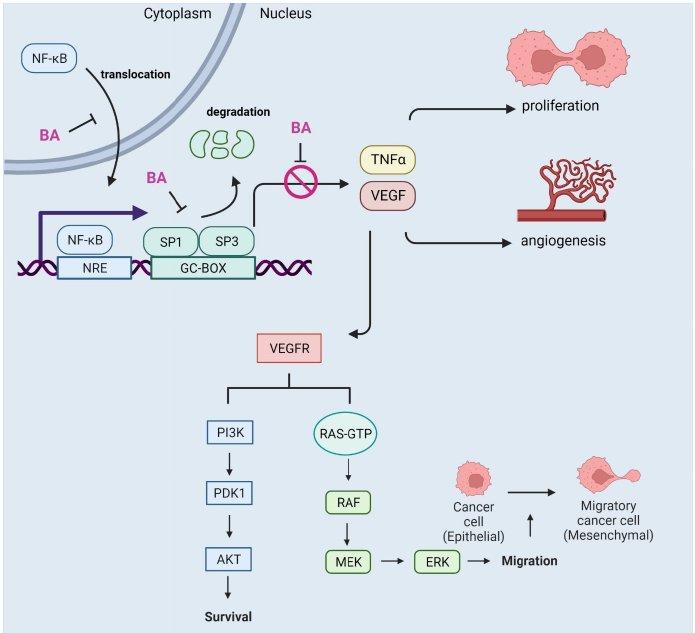
Figure 3. Tumor necrosis factor α (TNF ‐α ) and vascular endothelial growth factor (VEGF) with pro ‐ angiogenic function are overexpressed in tumors depending on transcription factors, i.e., tran ‐ scription factor Sp1 (SP1) and transcription factor Sp3 (SP3). They are supported by the nuclear factor kappa ‐ light ‐ chain ‐ enhancer of activated B cells (NF ‐κ B), which bind to specific sequences known as NF ‐κ B response elements (NRE) and GC ‐ BOXes. The presence of VEGF in the cell en ‐ hances the activation of the rat sarcoma virus ‐ GTP (RAS ‐ GTP)/RAF proto ‐ oncogene ser ‐ ine/threonine ‐ protein kinase (RAF)/mitogen ‐ activated protein kinase (MEK)/extracellular signal ‐ regulated kinase (ERK) and phosphoinositide 3 ‐ kinase (PI3K)/phosphatidylinositol kinase (PDK ‐ 1)/protein kinase B (AKT) pathways, promoting invasive potential and tumor metastases. Betulin ‐ ic acid (BA) prevents the translocation of NF ‐κ B to the nucleus and promotes the degradation of SP1 and SP3, down ‐ regulating VEGF. Created with BioRender.com (accessed on 22 March 2023). Apoptosis is reportedly not the only BA ‐ initiated cell death ‐ related process. Au ‐ tophagy is a catabolic process involving the massive degradation of cytoplasm and or ‐ ganelles through fusion with lysosomes [133]. Although the process physiologically me ‐ diates cell survival under stress conditions, it has been suggested that it may also be ex ‐ ploited to specifically target cancer cells [133]. Several different types of autophagy in ‐ volve complex pathways and multiple protein factors. Among the best ‐ studied proteins that trigger autophagy are mammalian target of rapamycin complex 1 (mTORC1) and 5 ′ AMP ‐ activated protein kinase ( AMPK). mTORC1 is a protein complex composed of mTOR kinase and mTOR associated protein LST8 homolog (MLST8) [134]. Acting as a negative regulator, mTORC1 phosphorylates proteins essential for the occurrence of au ‐ tophagy, i.e., autophagy ‐ associated protein 13 (ATG13) and Unc ‐ 51 like autophagy acti ‐ vating kinase (ULK1), inhibit their activity [133–135]. The role of AMPK is to promote autophagy by inducing ULK1 [134]. Inactivation of mTORC1 combined with simultane ‐ ous activation of AMPK drives the formation of a phagophore structure from intracellu ‐